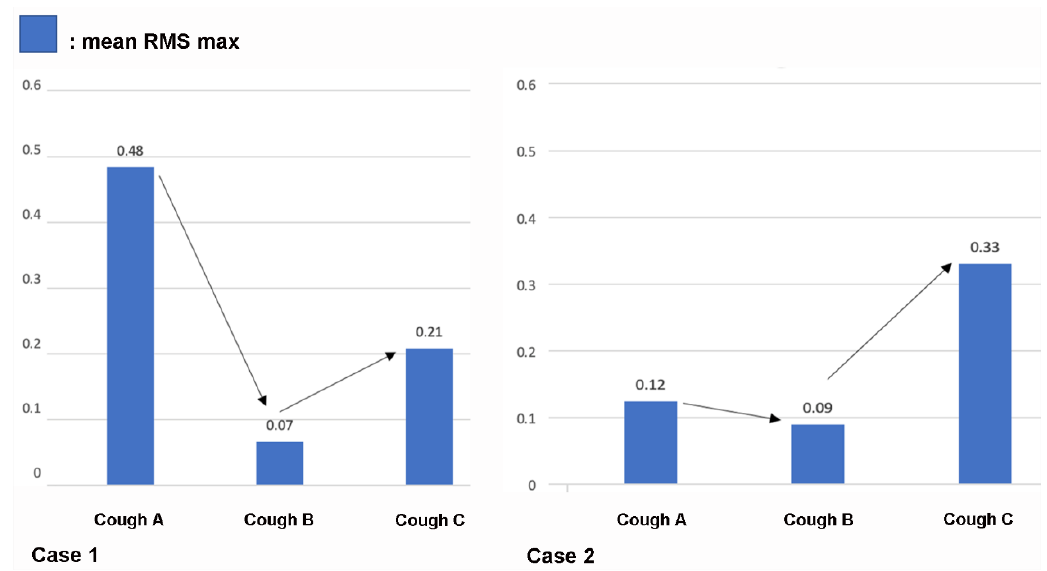
Figure 5. Digital cough sounds from two normal cases for cough ( A , B ), that can be divided into two or three phases (explosive, intermediate, and voiced) are shown. RMS = root mean square.